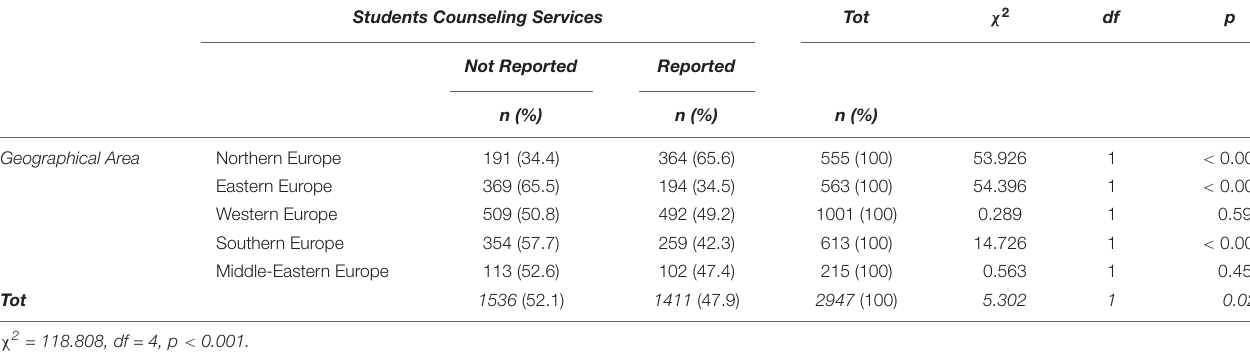
TABLE 4 | Presence of student counseling services in different European geographical areas.